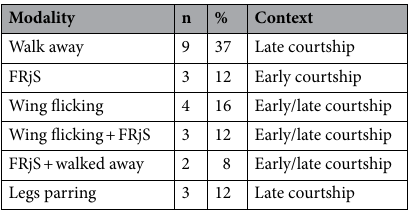
Table 3. Behaviors characterizing the female